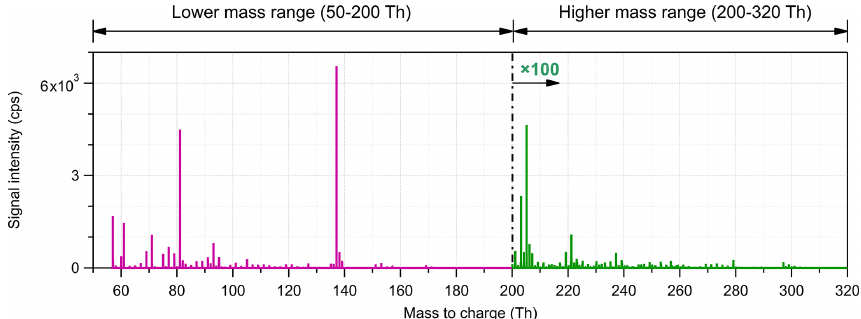
Figure 1. Average mass spectrum measured in the Landes forest. The mass spectrum is divided into two subranges for further source identification analysis. The intensity scale is shown 100-fold for the high-mass range